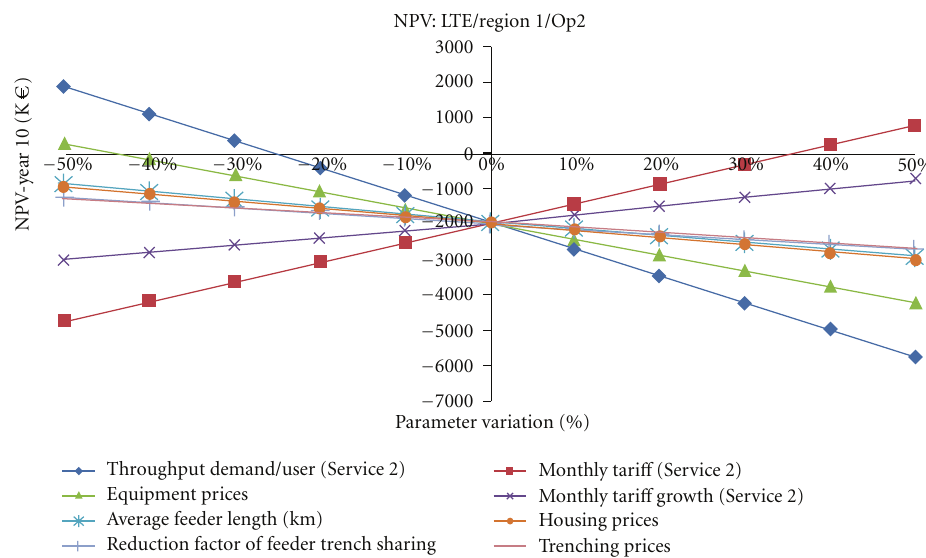
Figure 7: Sensitivity analysis results, LTE/urban area/new